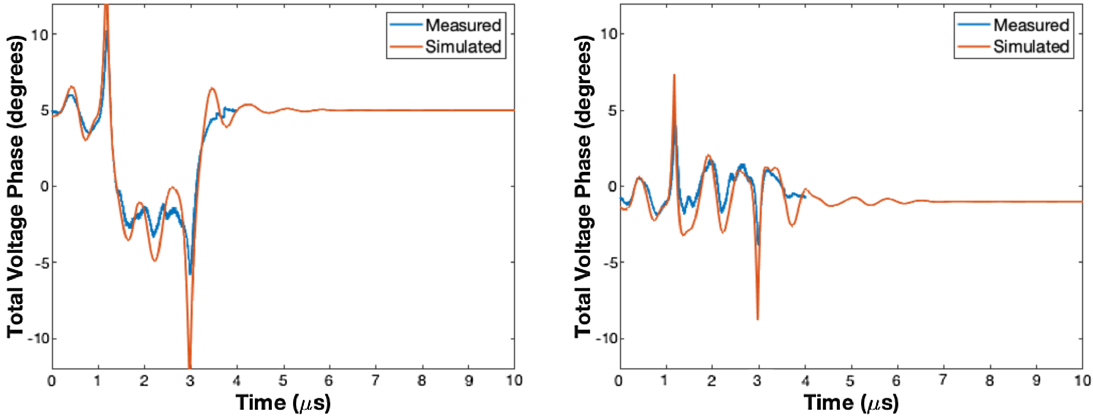
FIG. 6. Measured and simulated total cavity voltage phase, with feedforward off (left) and feedforward on (right). Feedback is on for both